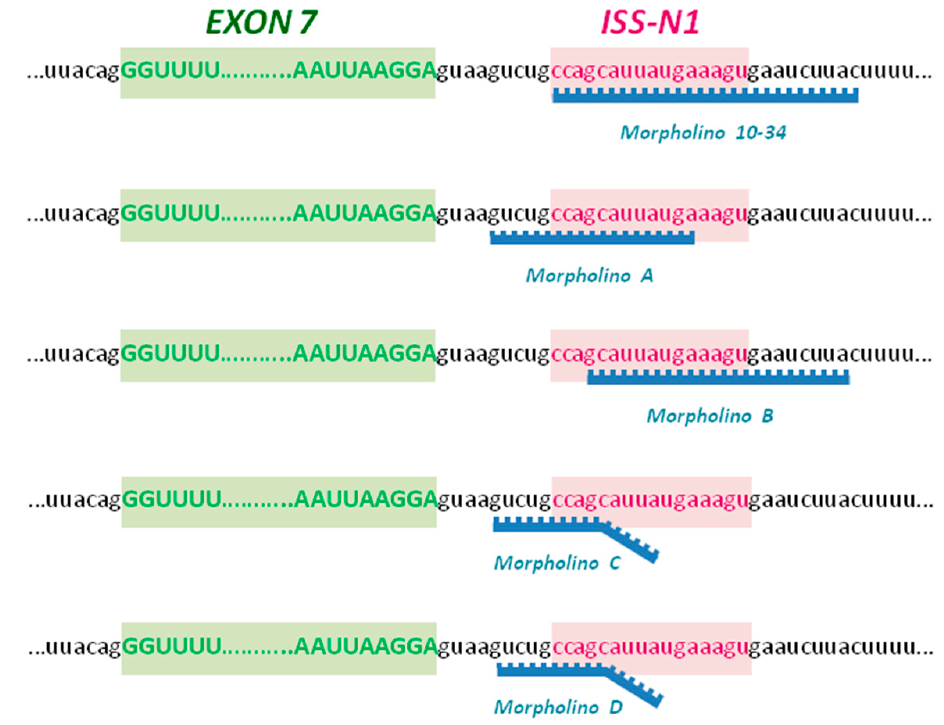
Figure 1. Morpholino (MO) sequences design. We designed four new MO sequences (A, B, C and D) against the negative intronic splicing silencer (ISS-N1) of survival motor neuron 2 ( SMN2 ), downstream of exon 7, that differed in the binding site compared to the already validated MO-10-34. The MO A and MO B sequences have perfectly complementary sequences to their target site, while only the first 10 nucleotides of MO C and MO D perfectly match with the target sequence within ISS-N1.